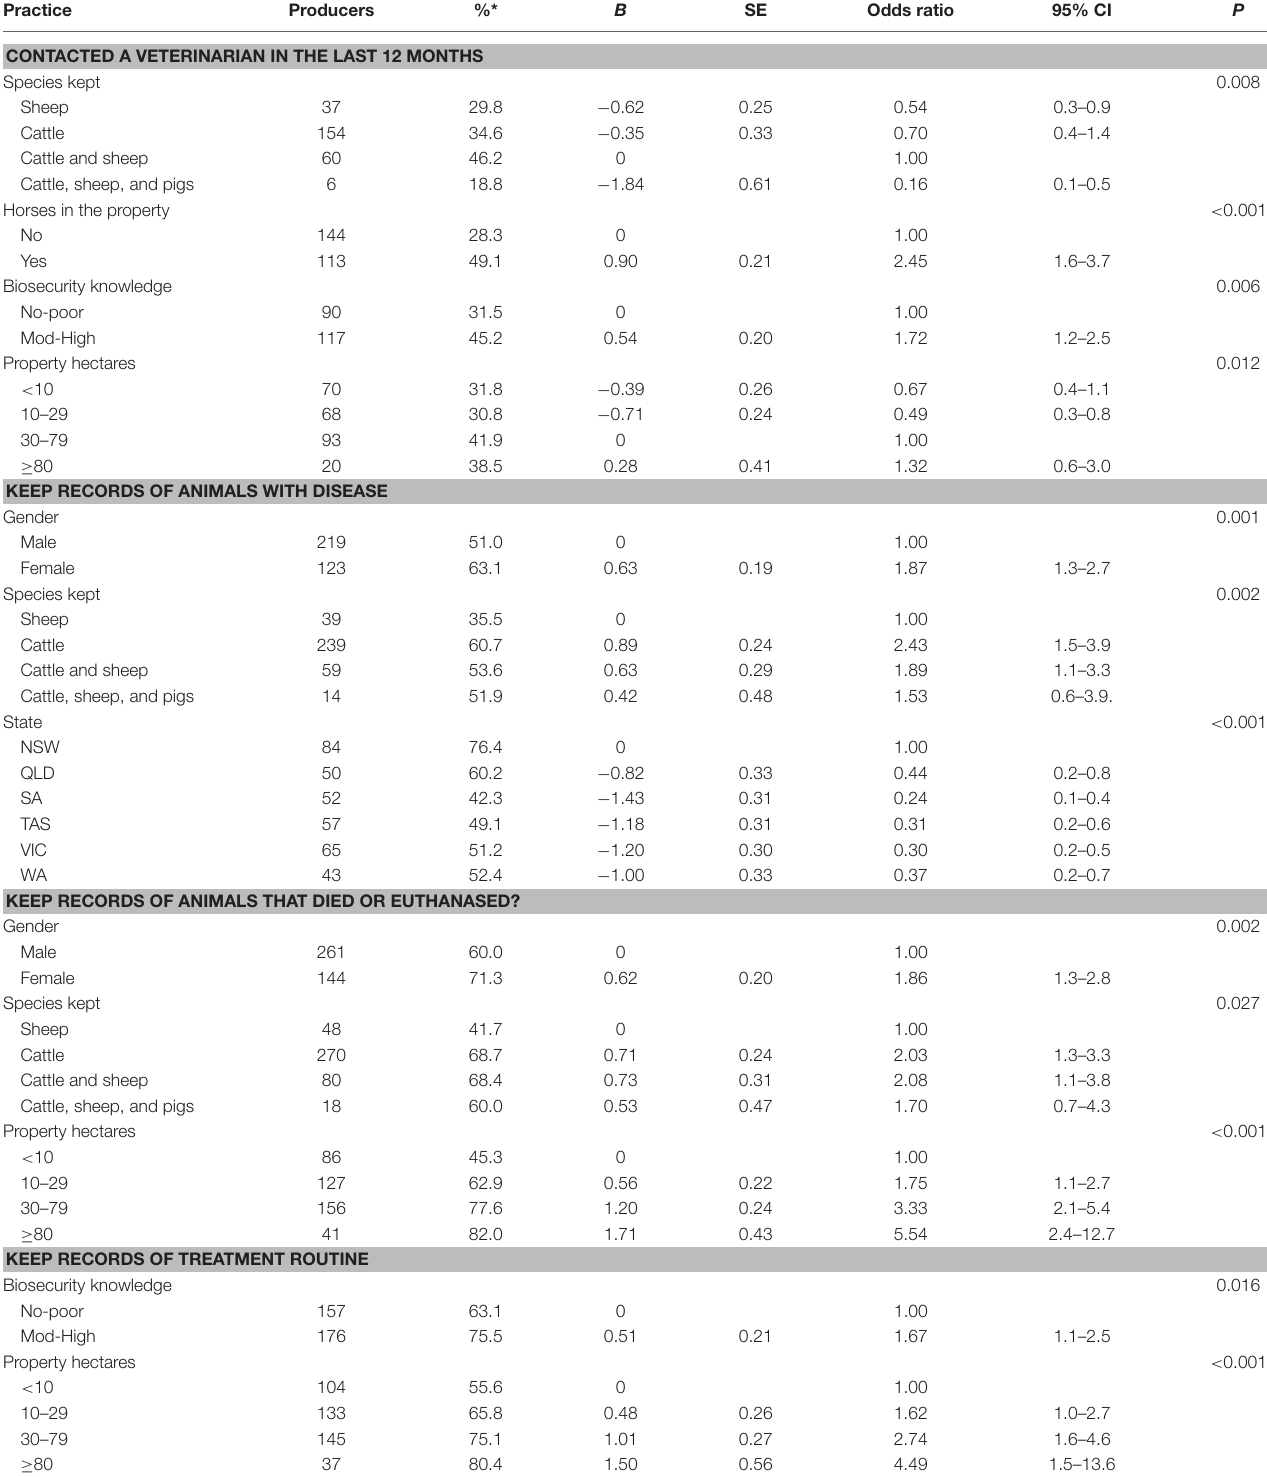
TABLE 3 | Results of a multivariable logistic regression analysis investigating animal health management practices (contact with veterinarians and record keeping as dependent variables) of 746 smallholders keeping cattle and sheep participating in a cross-sectional study in Australia in 2013–2015 (Only significant associations are